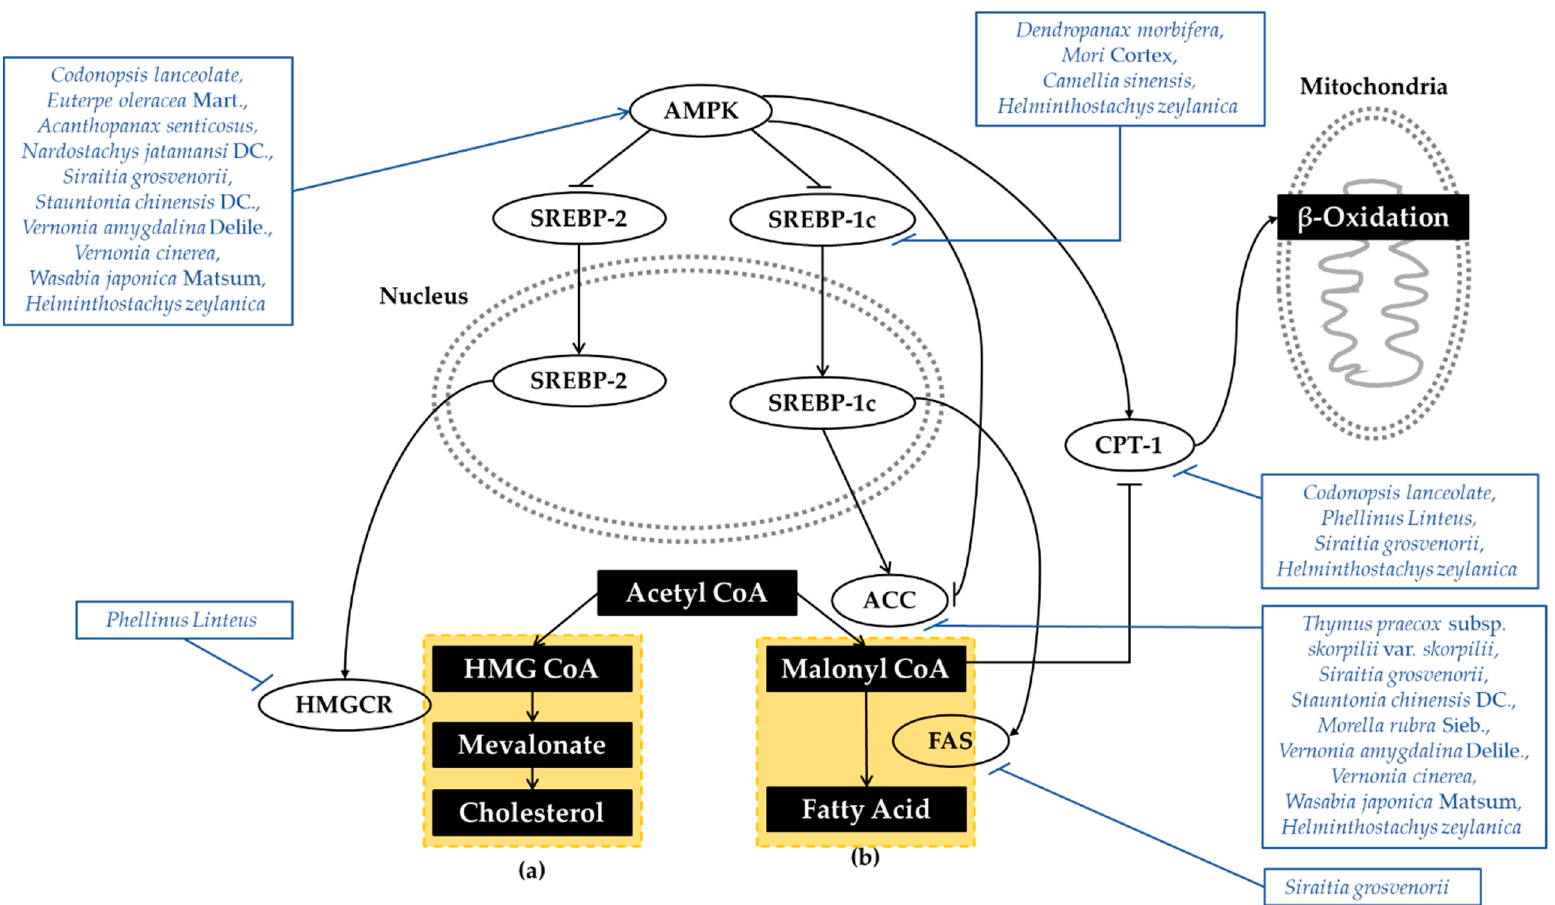
Figure 3. Schematic Diagram of Lipid Metabolism. AMPK inhibits SREBP and ACC, which are factors that activate cholesterol and fatty acid synthesis. AMPK is also associated with fatty acid oxidation by modulating CPT-1. Plant extracts were capable of regulating AMPK, as well as other related enzymes, which ultimately altered the state of lipid metabolism in type 2 diabetes. ( a ) Cholesterol synthesis, ( b ) fatty acid synthesis. (AMPK, Adenosine 5 ′ -monophosphate-activated protein kinase; SREBP, Sterol regulatory element binding proteins; CPT-1, Carnitine palmitoyltransferase 1; ACC, Acetyl-CoA carboxylase; HMGCR, 3-hydroxy-3-methylglutaryl-CoA reductase; FAS, fatty acid synthase; Acetyl CoA, Acetyl-coenzyme A; HMG CoA, 3-hydroxy-3-methylglutaryl-coenzyme A.)